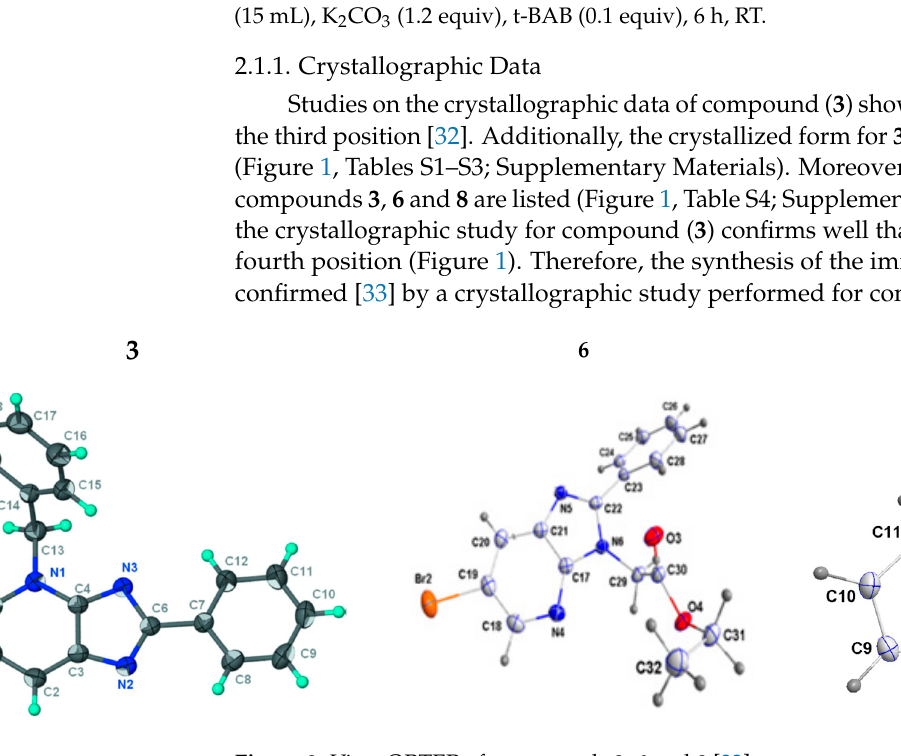
Figure 2. View ORTEP of compounds 3 , 6 and 8 [36].